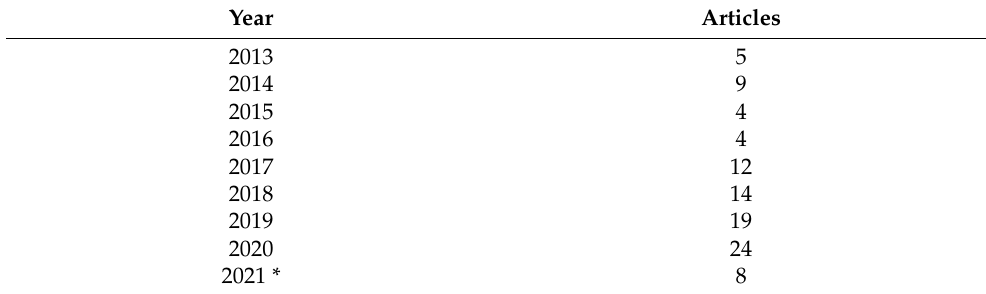
Table 6. Annual publications of journal articles on BIM–IoT integration for FM (* until February 2021).